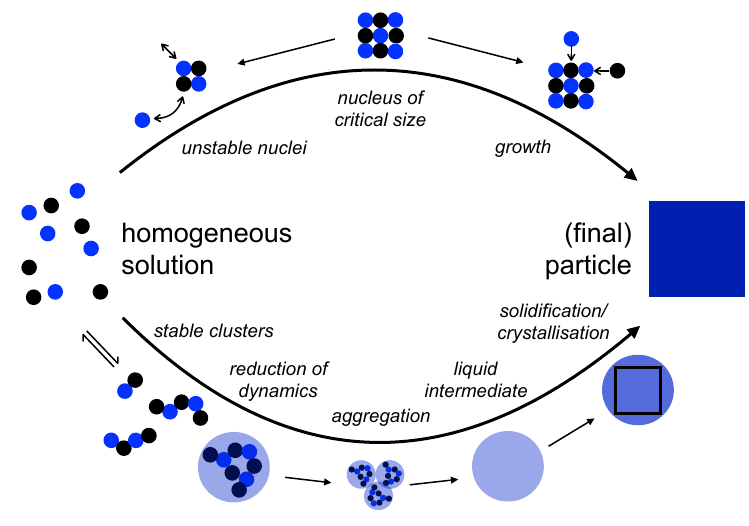
Figure 1. Schematic illustration of the mechanism of nucleation according to classical nucleation theory (CNT, top) and the pre-nucleation cluster (PNC) pathway (bottom). For different polymorphs or